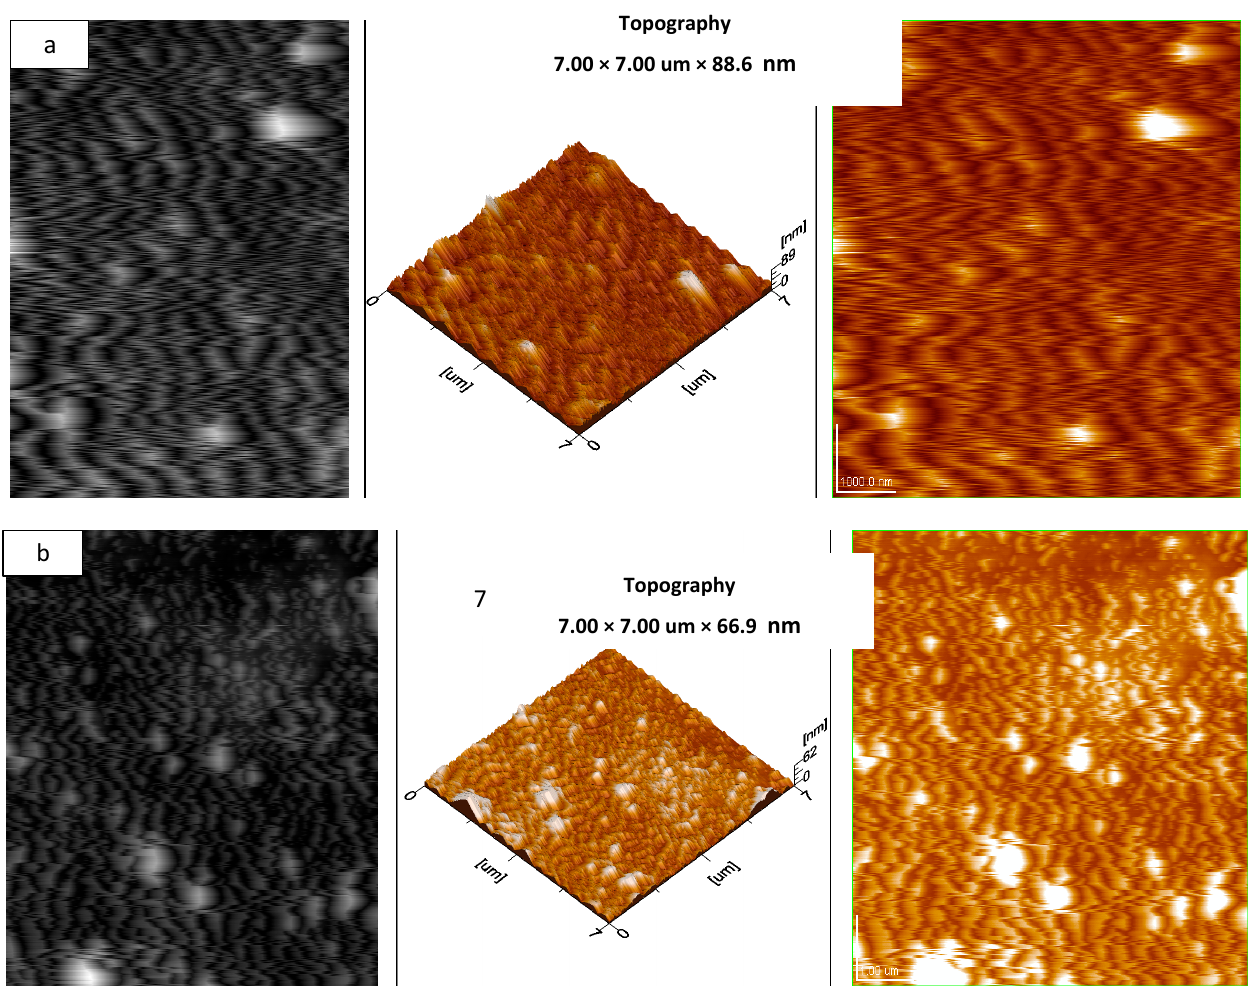
Figure 5. AFM images of: ( a ) NCP 3 and ( b ) CCP 3.